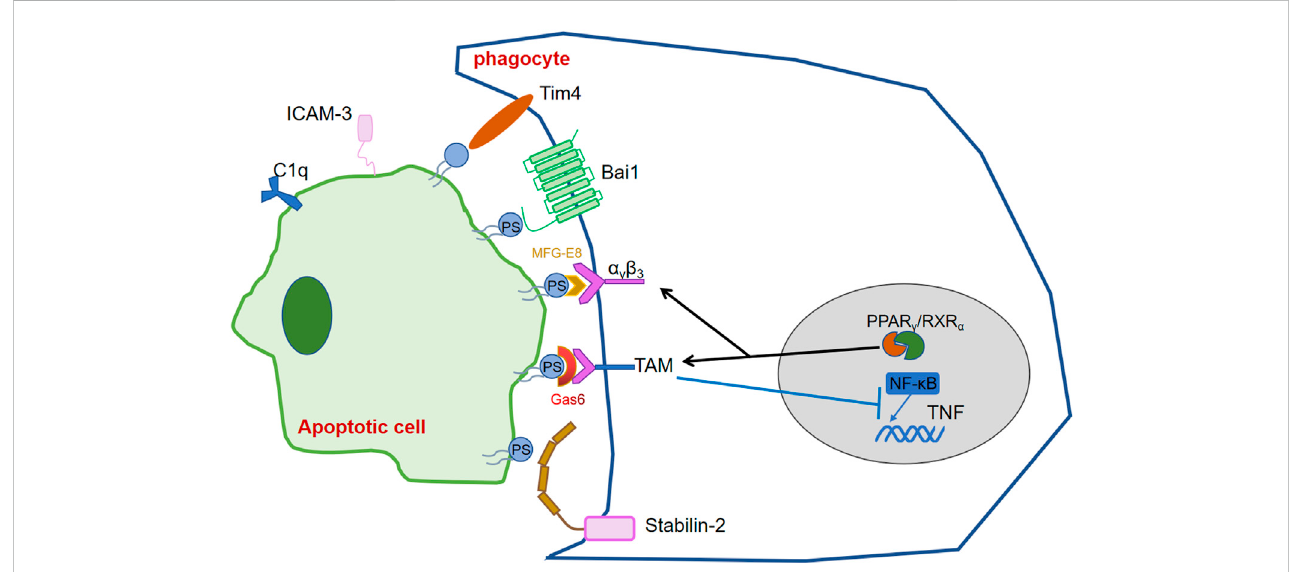
FIGURE 3 Transcription factors regulating the release and recognition of “ eat me ” signals.